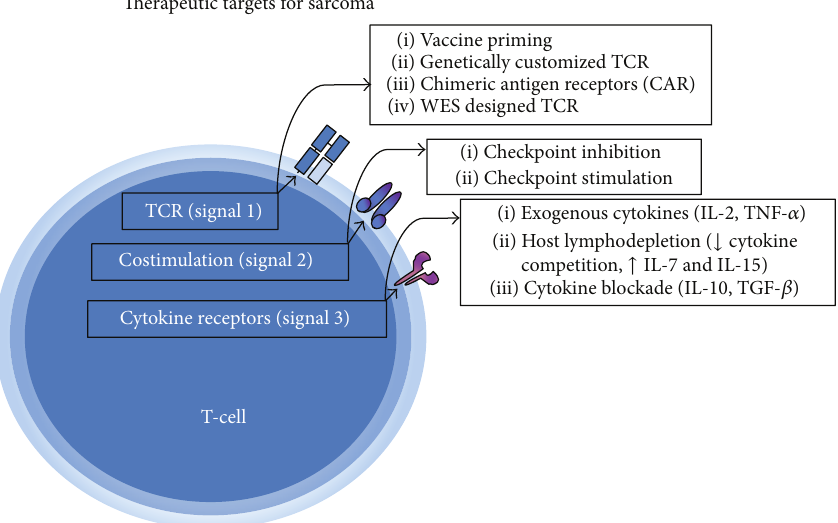
Figure 1: The stepwise signaling necessary for T-cell activation against tumor targets represents areas of active investigation for the immunotherapy of sarcoma (TCR: T-cell receptor; WES: whole exome sequencing).